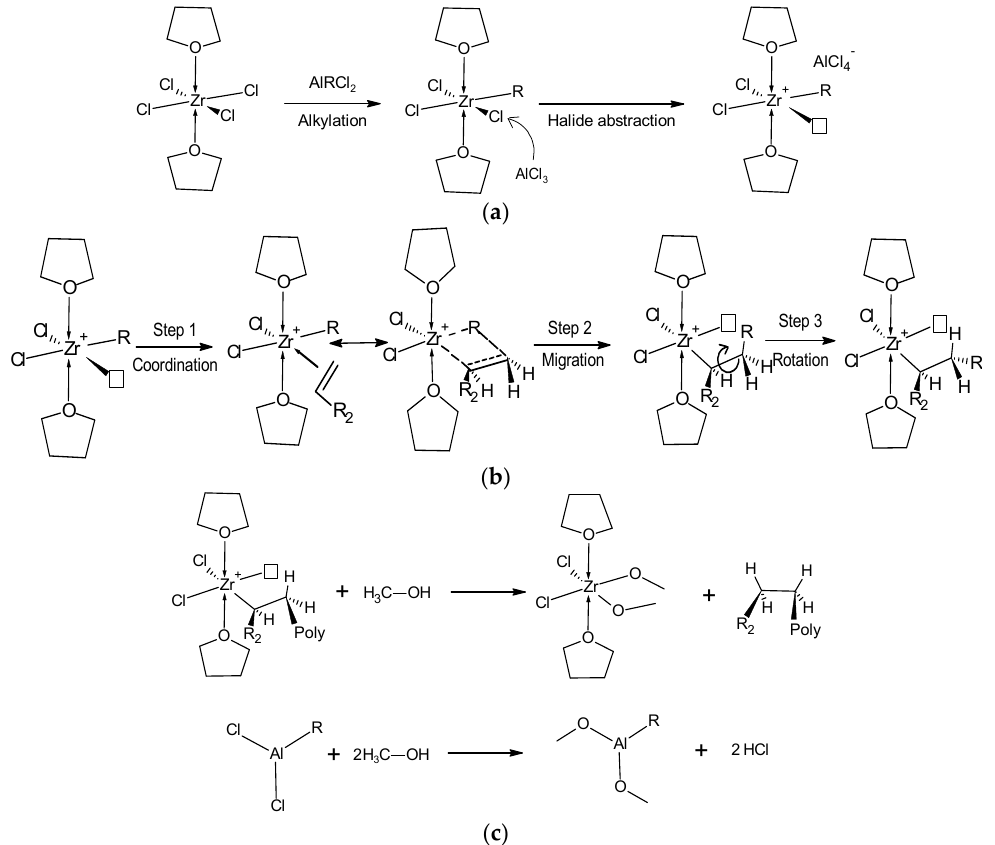
Figure 2. Ziegler–Natta polymerization: ( a ) Activation of the catalyst. The arrows represent the coordination bonds and the square, a vacant position; ( b ) Propagation reaction. R 2 represents the pendent group of the monomer, it can be aliphatic or aromatic; ( c ) Termination reaction.